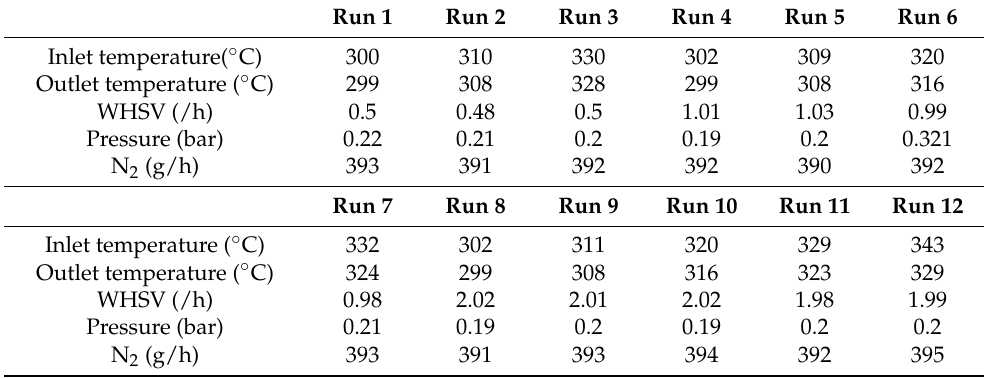
Table 1. The testing